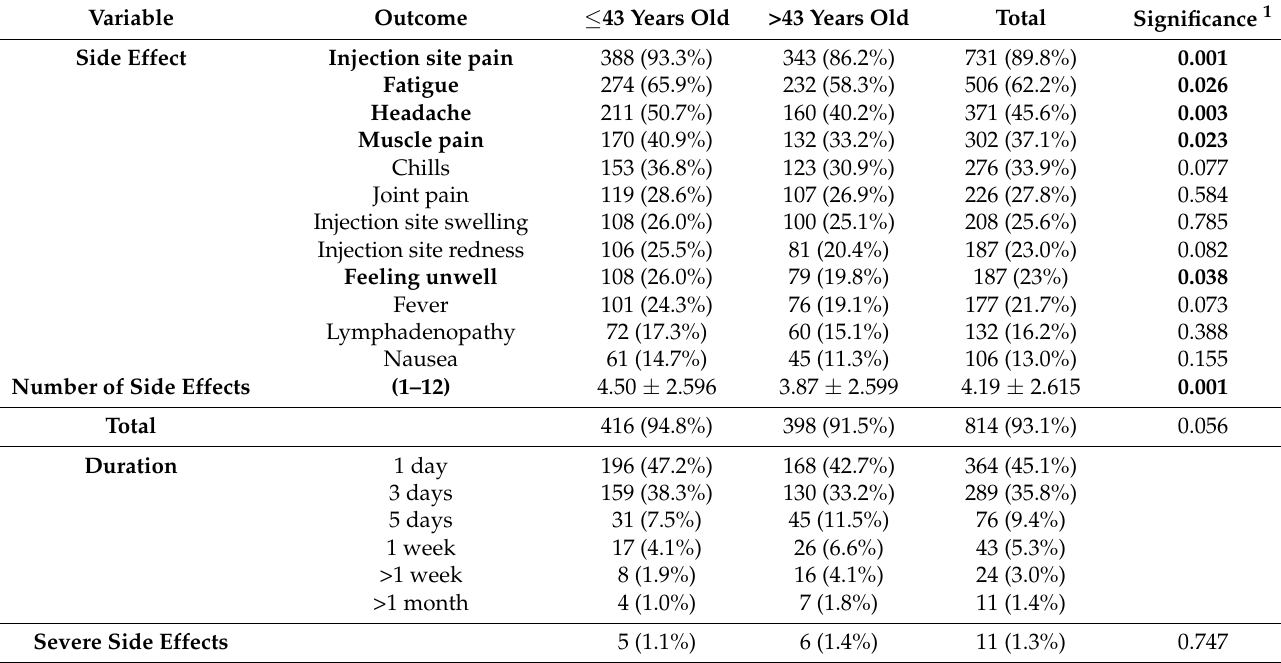
Table 6. Prevalence of the general side effects of Pfizer–BioNTech COVID-19 vaccine among healthcare workers in the Czech Republic, January–February